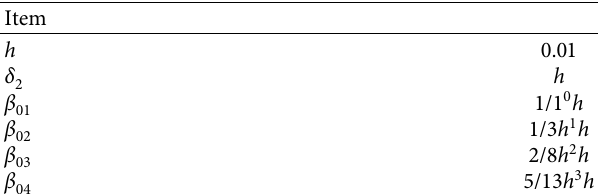
Figure 7: TD trend chart of sin ( 10 t ) . Table 3: ESO parameter table.